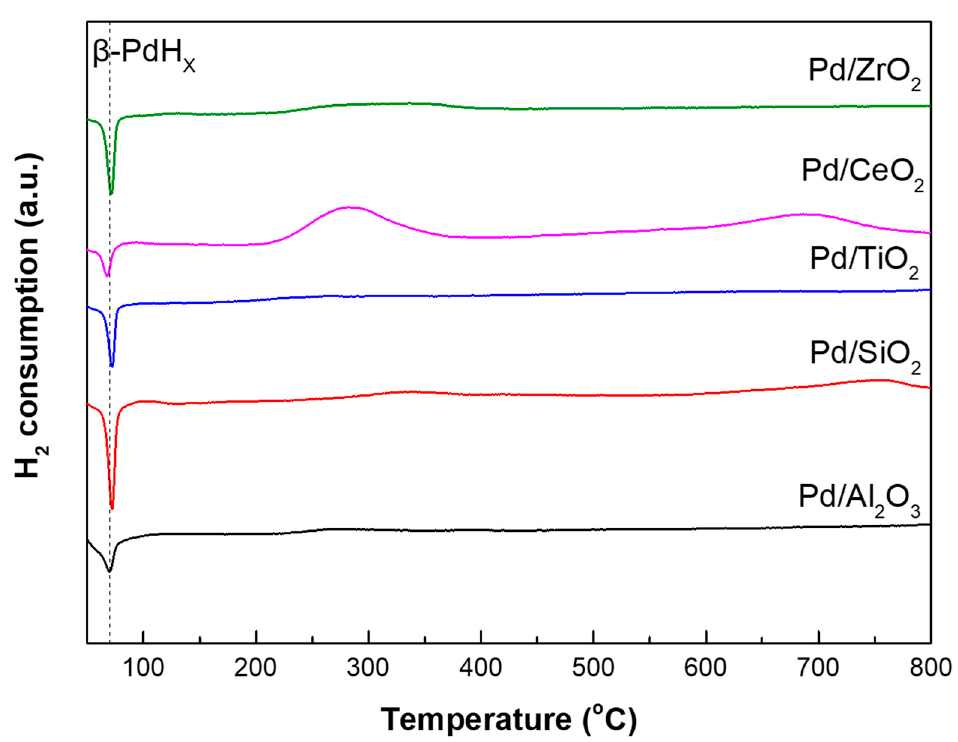
Figure 4. H 2 -TPR profiles of Pd catalysts.